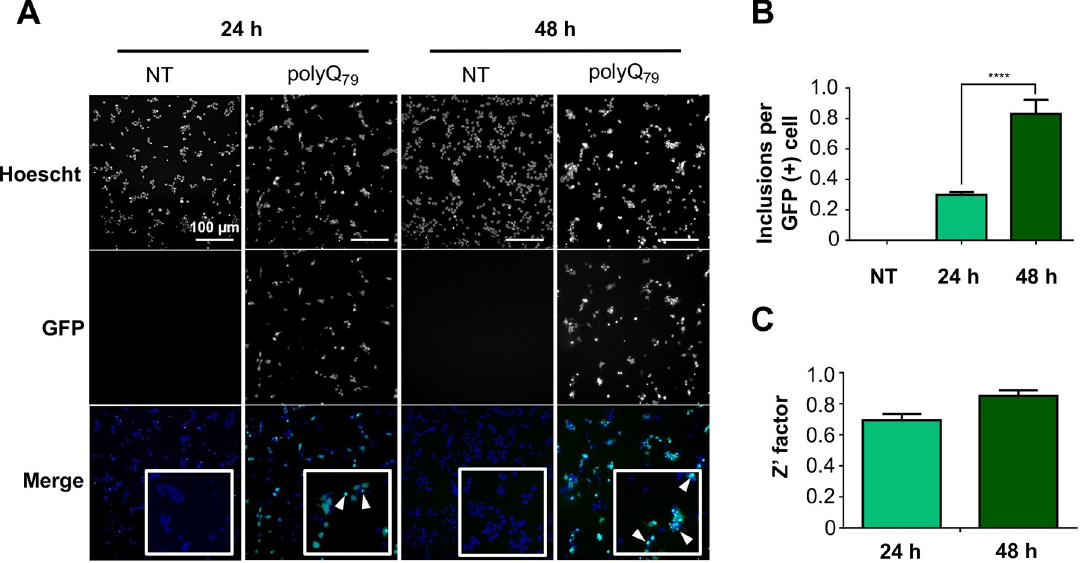
Fig 1. Analysis of polyQ 79 –EGFP intracellular inclusions and Z´-factor analysis. Cells were transfected with the polyQ 79 –EGFP plasmid and 24 h after transfection, treated with Hoescht reagent for nuclei staining. Images were acquired at 24 and 48 h after transfection using the cellomics platform. GFP-positive (GFP (+)) inclusions were quantified using the Spot detector application on the HCS Studio 1 software. (A) polyQ 79 –EGFP intracellular inclusion formation 24 and 48 h post transfection analyzed using fluorescent microscopy. (B) Quantification of polyQ 79 -EGFP inclusions per GFP (+) cell 24 and 48 h post transfection. C) Z’ factor analysis 24 and 48 h post transfection. Results are the mean ± SEM of 3 independent experiments. Statistically significant differences were detected by one–way ANOVA ( ���� = p < 0.0001).